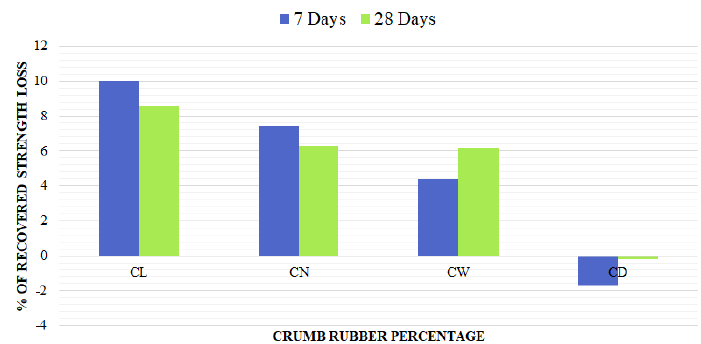
Figure 10. Percentage of recovered strength loss at 7 and 28 days.